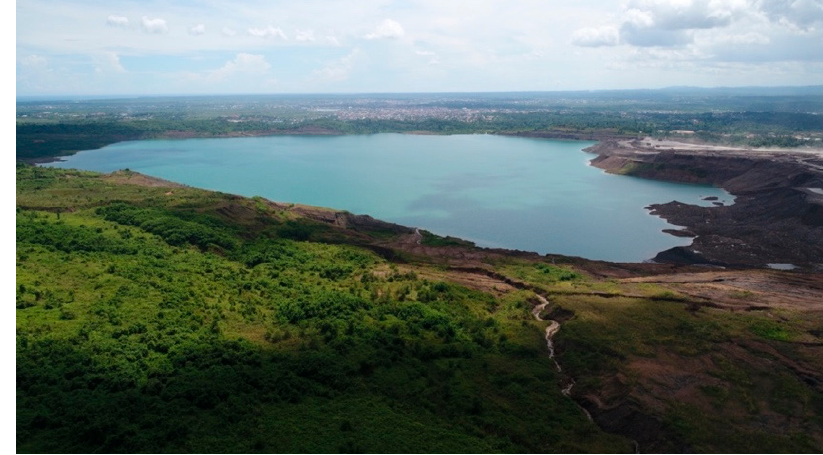
Figure 6. Actual Pit Lake J-Void.